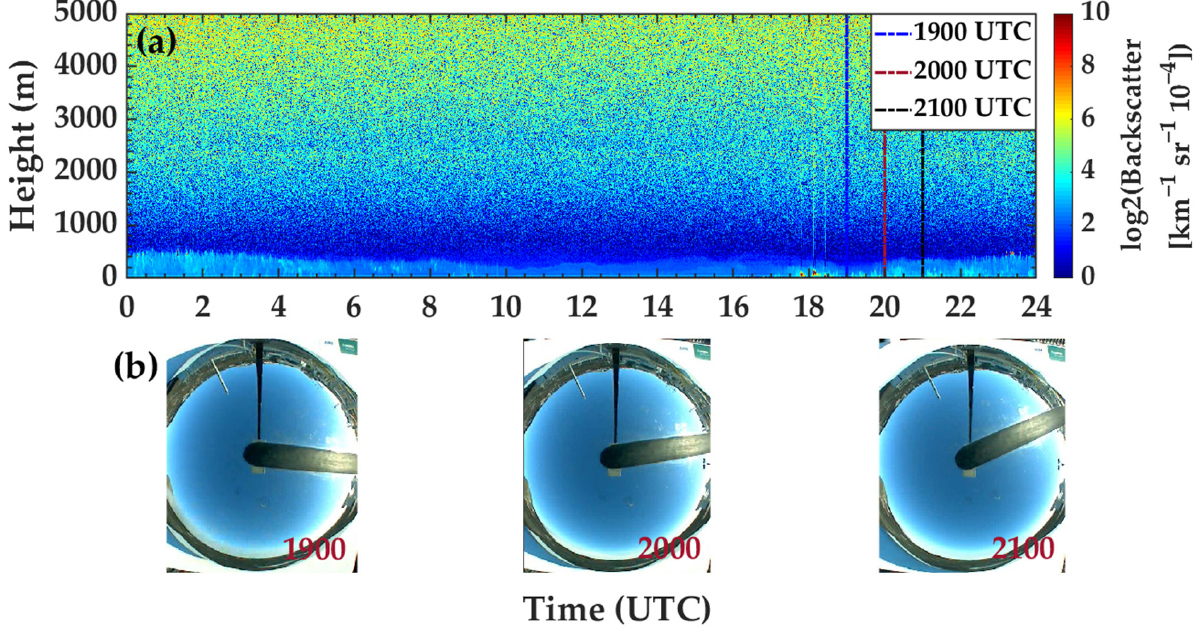
Figure 8. ( a ) Backscattered echo of ceilometer from on 14 December 2016. Blue dotted line corresponds to 1900 UTC, red dotted line corresponds to 2000 UTC, and black dotted line corresponds to 2100 UTC. ( b ) TSI images at 1900 UTC, 2000 UTC, and 2100 UTC on 14 December 2016.